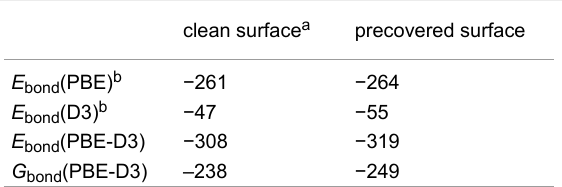
Table 2: Adsorption energies (in kJ·mol − 1 ) of 1 on a precovered Si(001) surface leading to 3 compared with the corresponding values for adsorption on a clean surface leading to 2 .